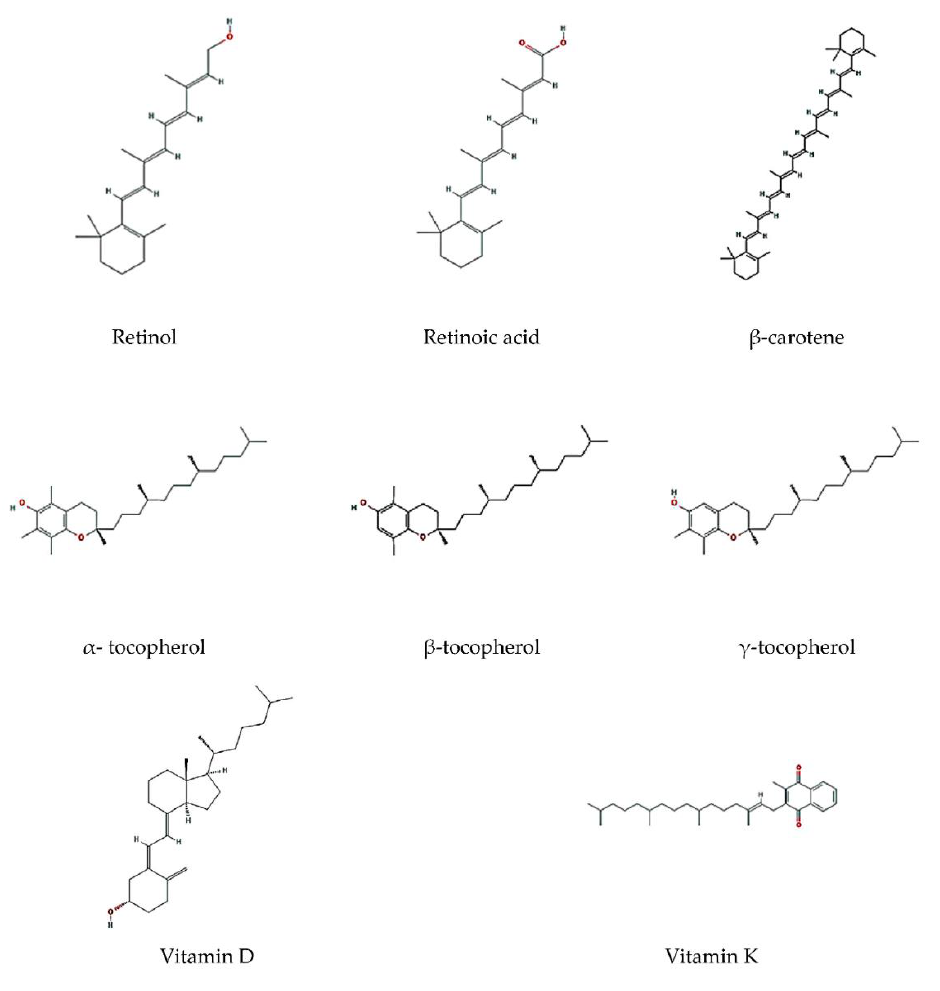
Figure 5. Chemical structures of some lipid-soluble vitamins.